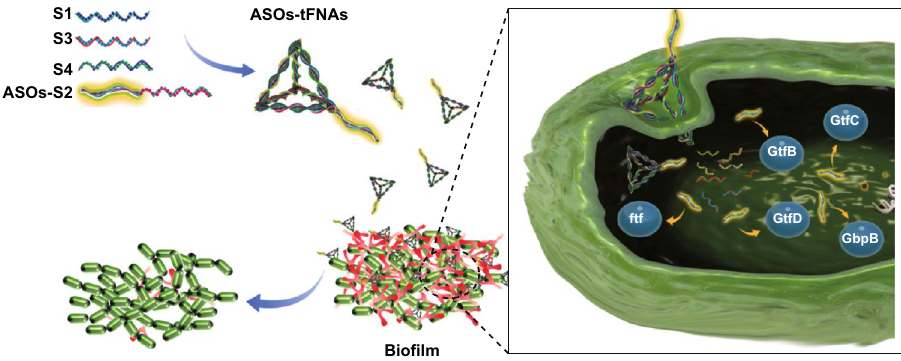
Fig. 6 Schematic representation of how tFNAs deliver ASOs to inhibit the formation of bacterial biofilms by targeting genes related to EPS